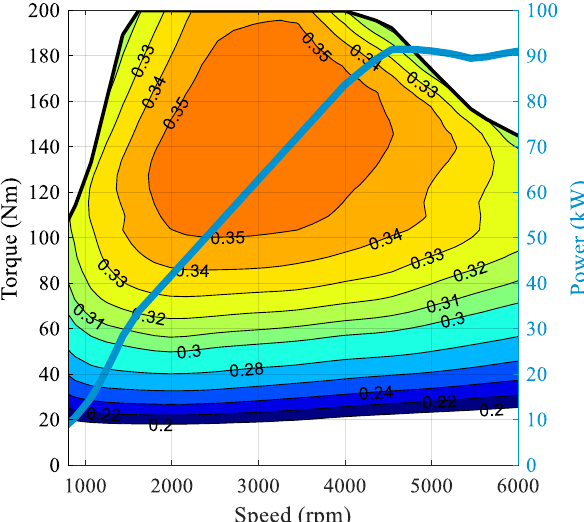
Figure 5. ICE efficiency map, maximum torque (black), and maximum power (blue).